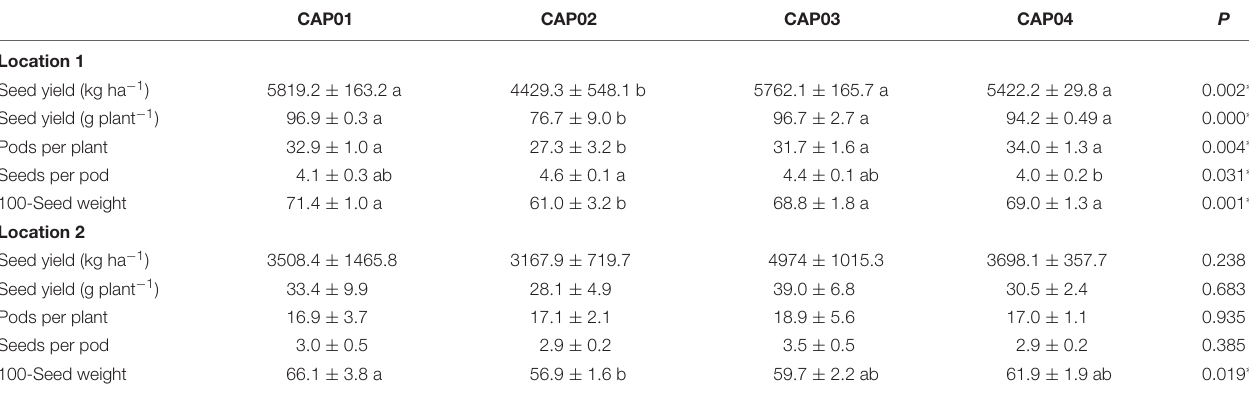
TABLE 3 | Mean values for agronomic traits in four Caparrona de Monzón bean accessions (CAP01, CAP02, CAP03, and CAP04) grown in two locations (1: Montañana and 2: Monzón).